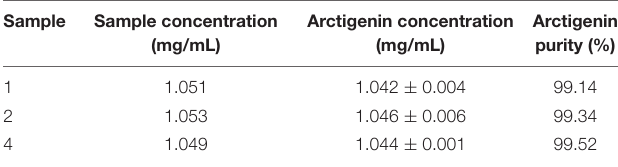
TABLE 1 | Arctigenin purity after purification.